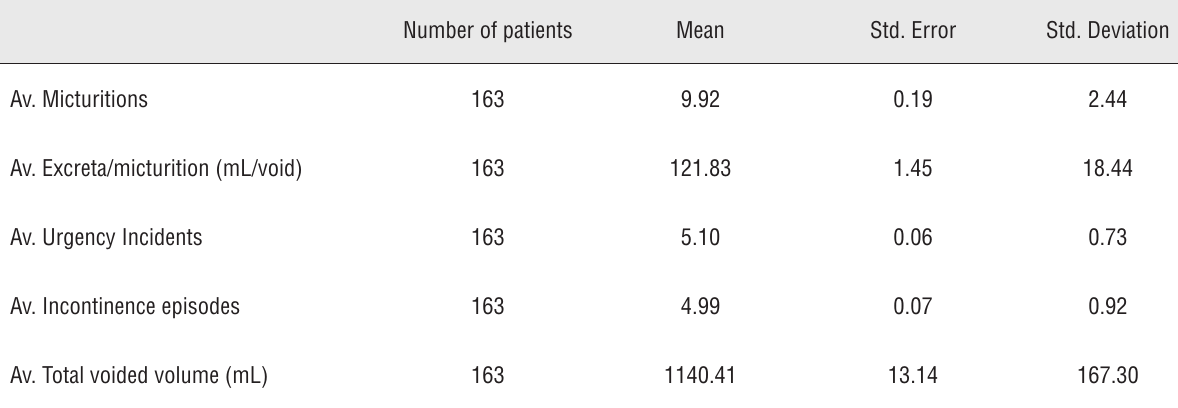
Table 1a - Descriptive statistics of the cohort. Average data derived from the completed diaries.